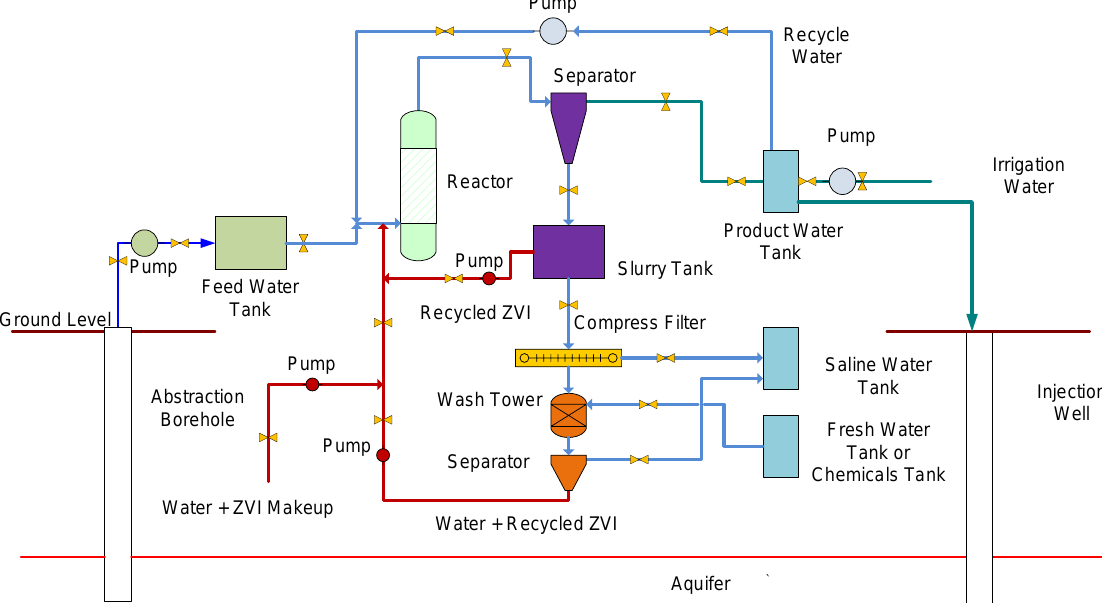
Figure A8. Process flow diagram used in the kinetic modeling. The section of aquifer shown is between the abstraction well (negative potential point) and the injection well (positive potential point) shown in Figure A7b. Fluid flow from the aquifer to the reactor via the abstraction well(s) = [C] (Figure A6); fluid flow from the reactor to the aquifer via the injection well(s) = [B] (Figure A6).